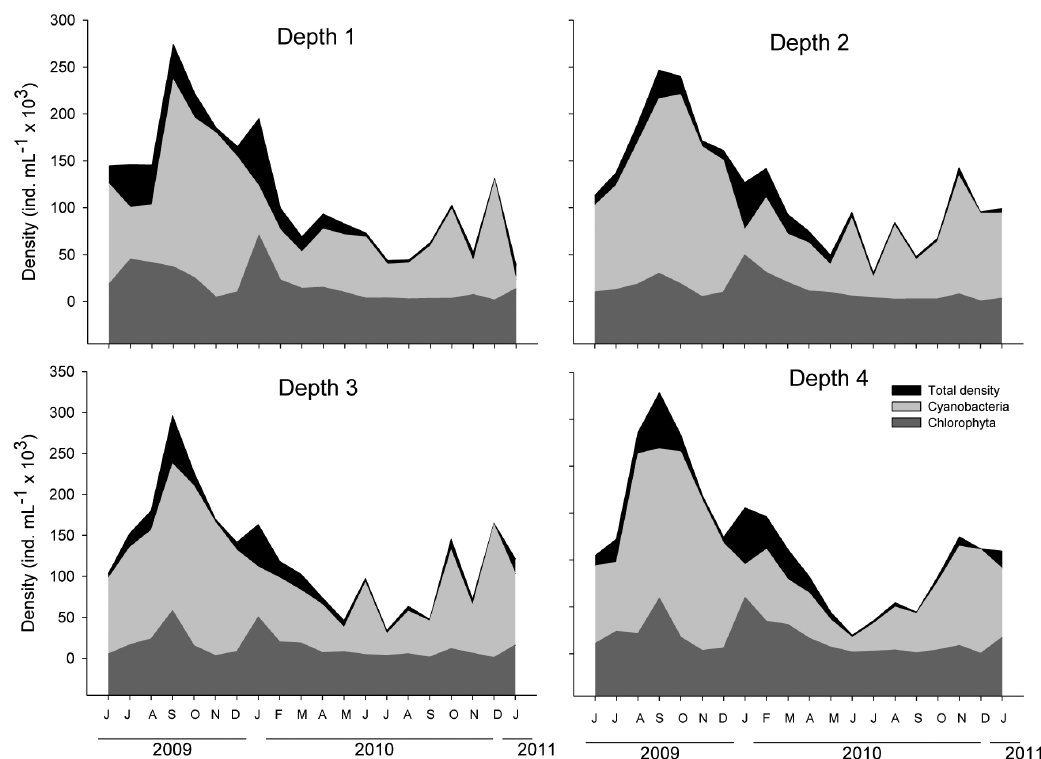
Figure 5. Total and groups phytoplankton density at four depths sampled in the Peri Lake, from June/2009 to